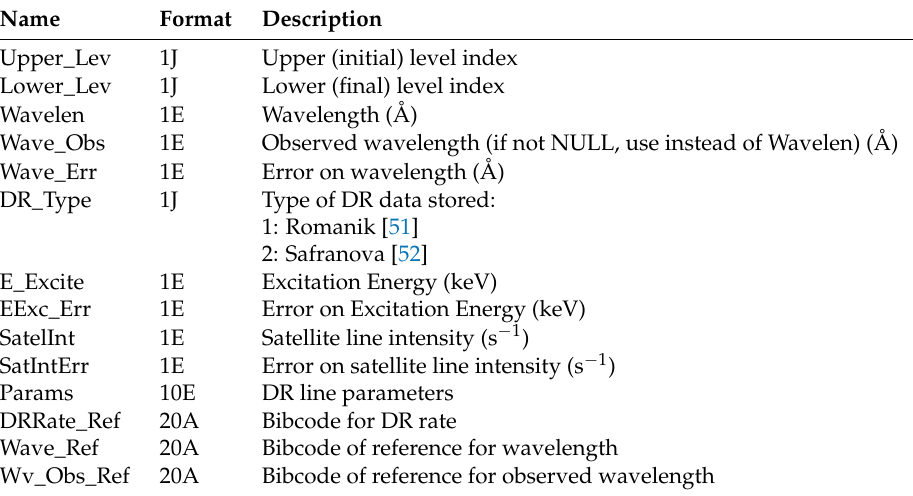
Table A6. APED DR (dielectronic recombination satellite line) file